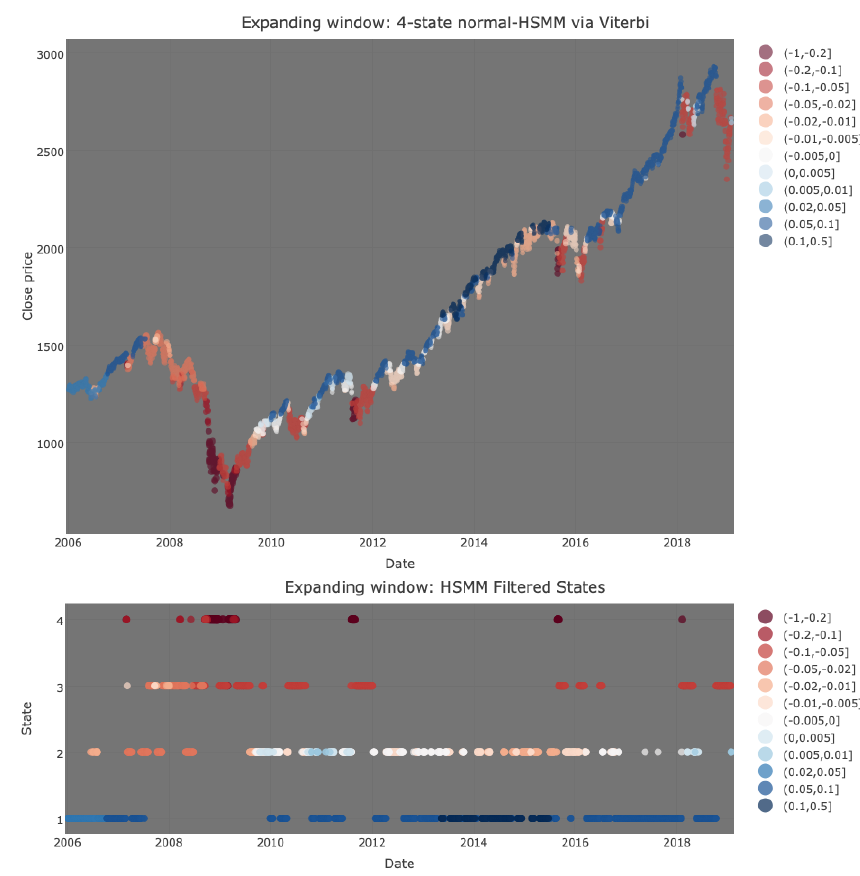
Figure 16. Expanding window: four-state normal HSMM filtering via the Viterbi algorithm on the S and P 500 Index. Upper figure: Colours vary by the value of the state-dependent mean (see legend), and the larger the state-dependent volatility, the larger the dot size. Lower figure: The plot indicates the inferred state at each time-point, and the colour code also indicates the value of the state-dependent mean as per the legend. Figure reproduced from